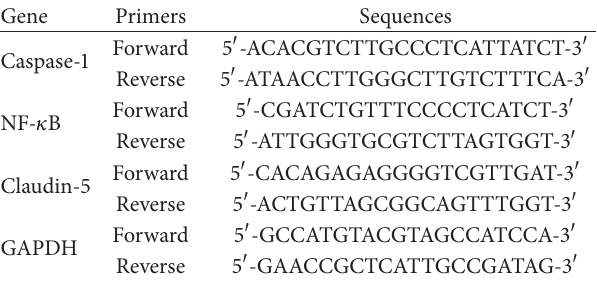
Table 1: Summary of the RT-PCR primers